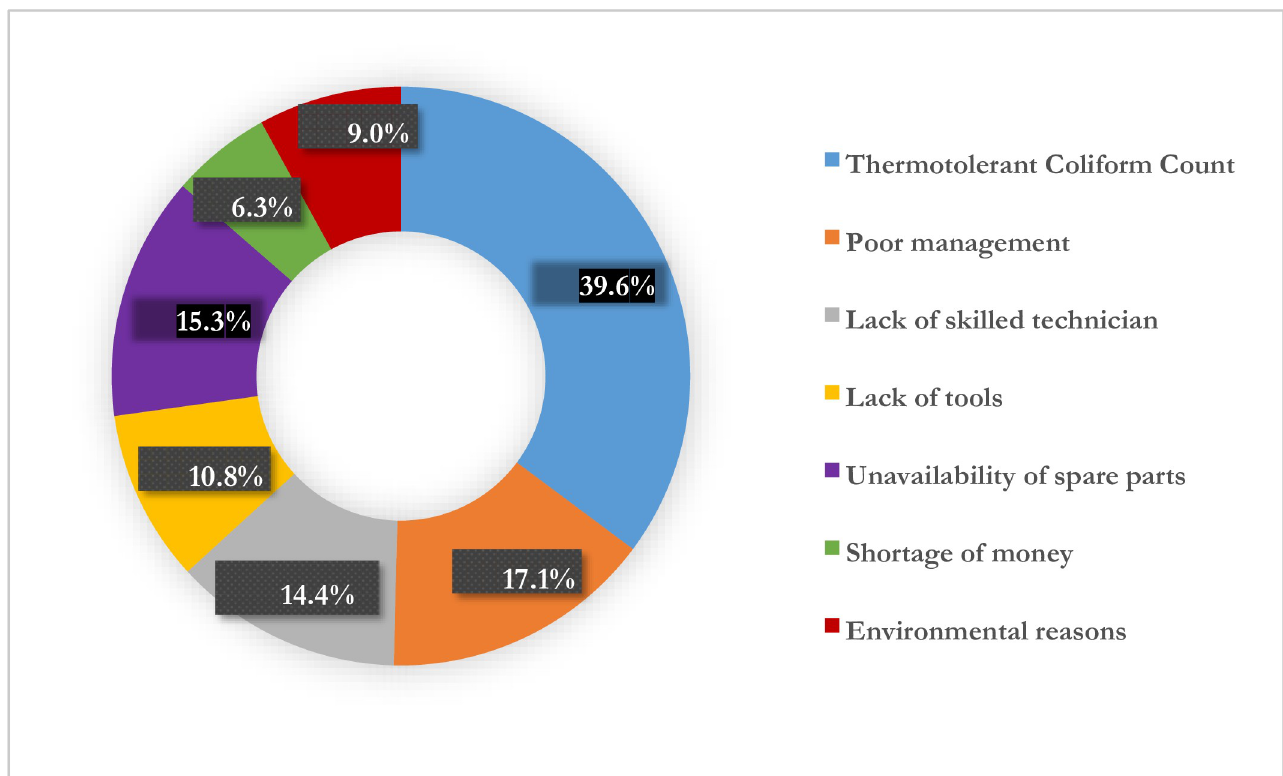
Fig 4. Factors resulting in basic water services non-functionality in Amhara and Afar regions,